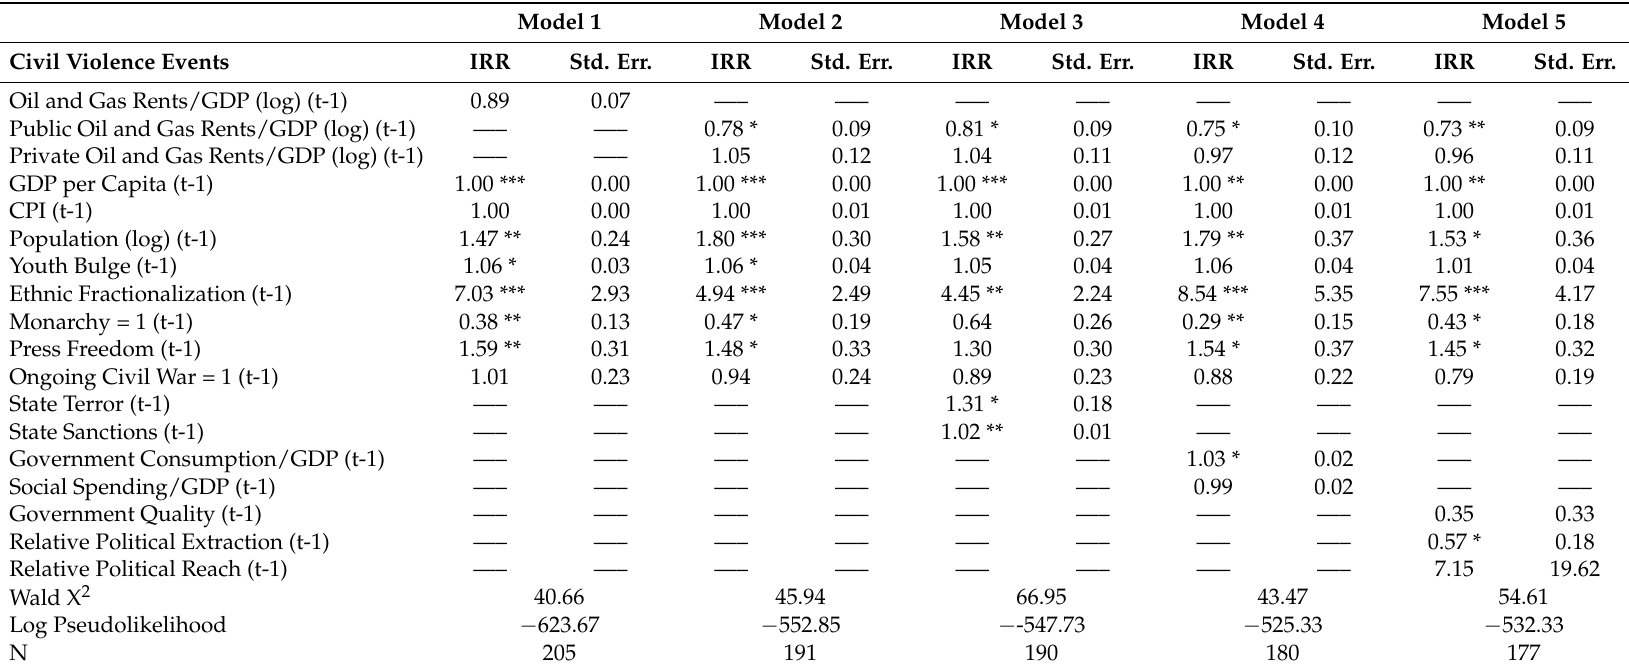
Table 2. Negative Binomial Regression Analysis of Civil Violence Events in the MENA Region,